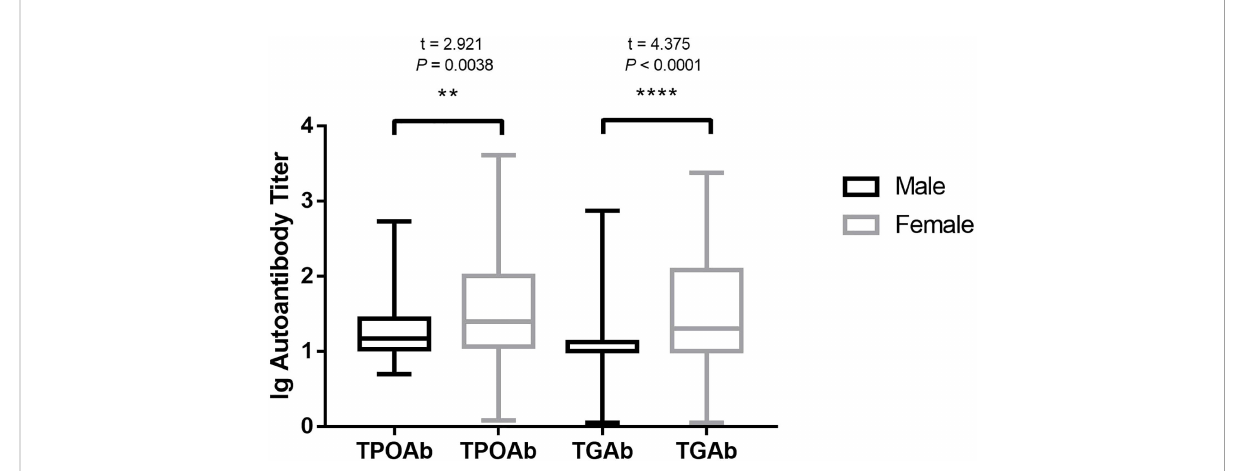
FIGURE 1 HT autoantibody in different sexes of patients with OLP. HT, Hashimoto ’ s thyroiditis; OLP, oral lichen planus; TPOAb, thyroid peroxidase antibodies; TgAb, thyroglobulin antibodies. **P < 0.01. ****P <